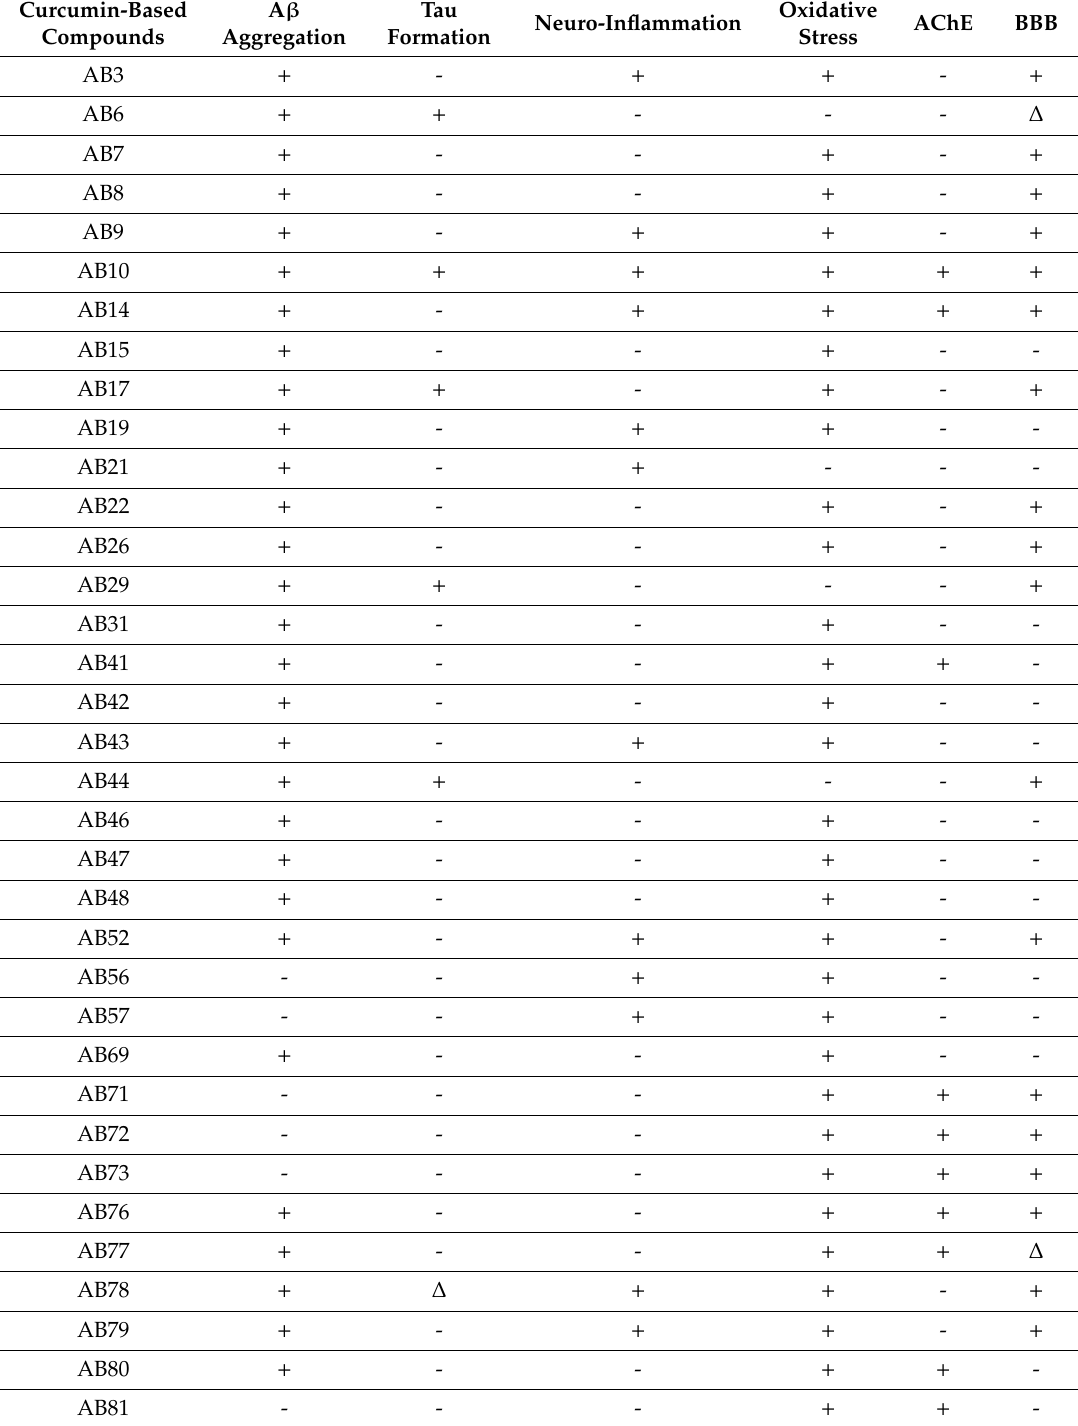
Oxidative Stress